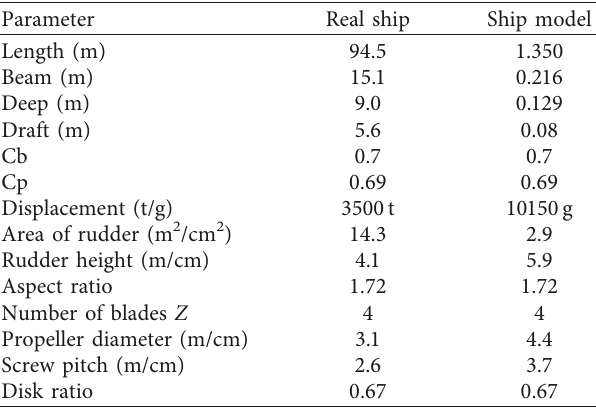
Table 1: Primary parameters of the ship.